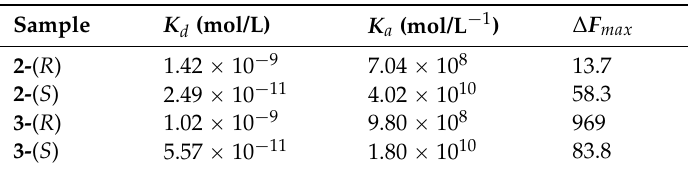
Figure 7. Frequency change of the Au electrodes on quartz crystals coated with BSA after addition of ( a ) 2 -( R ) ( ○ ) and 2 -( S ) ( △ ); ( b ) 3 -( R ) ( ○ ) and 3 -( S ) ( △ ). Table 2. Association constant ( K a ) of synthesized CAs ( 2 -( R ), 2 -( S ), 3 -( R ) and 3 -( S )) with bovine serum albumin (BSA).